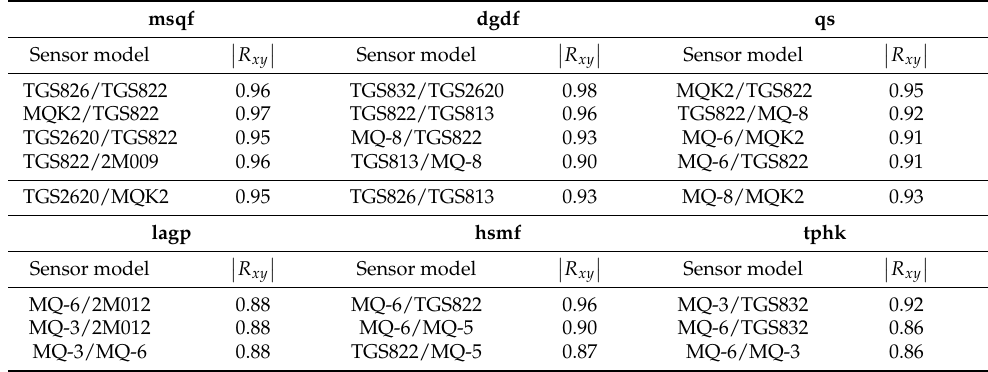
Table 3. Sensors with high correlation coefficient in detecting a certain